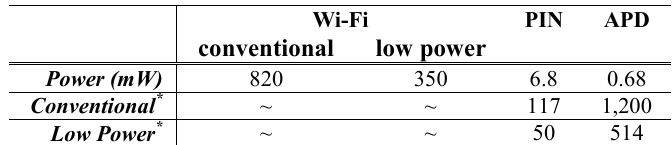
Table 3 Comparison of the transmit power